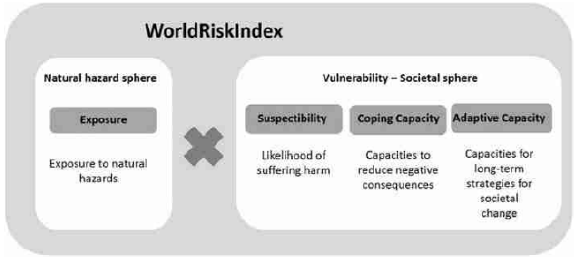
Figure 2. Risk formula of the World Risk Index (Welle & Birkmann 2015b)